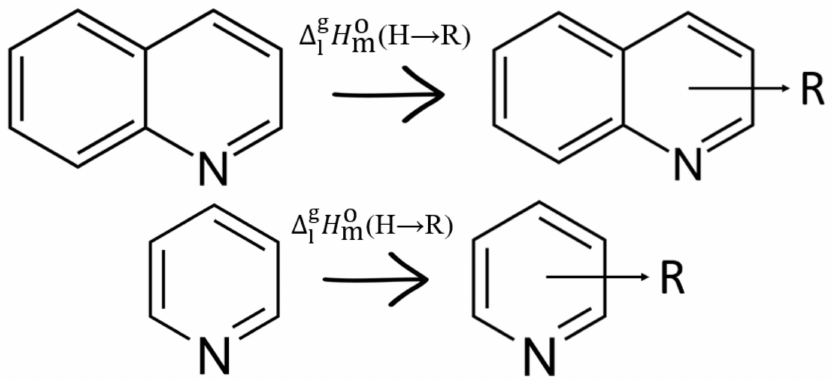
H o m (298.15 K), of ethyl-substituted quinolines l